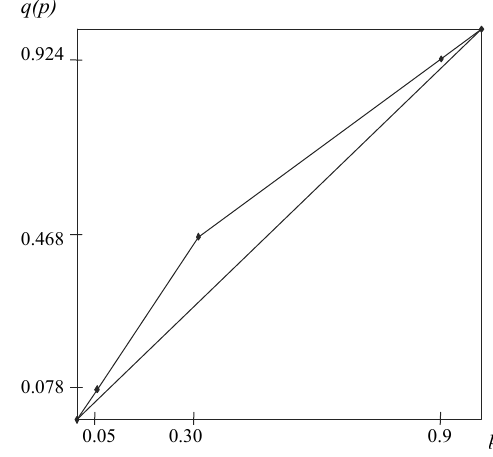
Figure 3 – Example of Quiggin’s transformation function q ( p